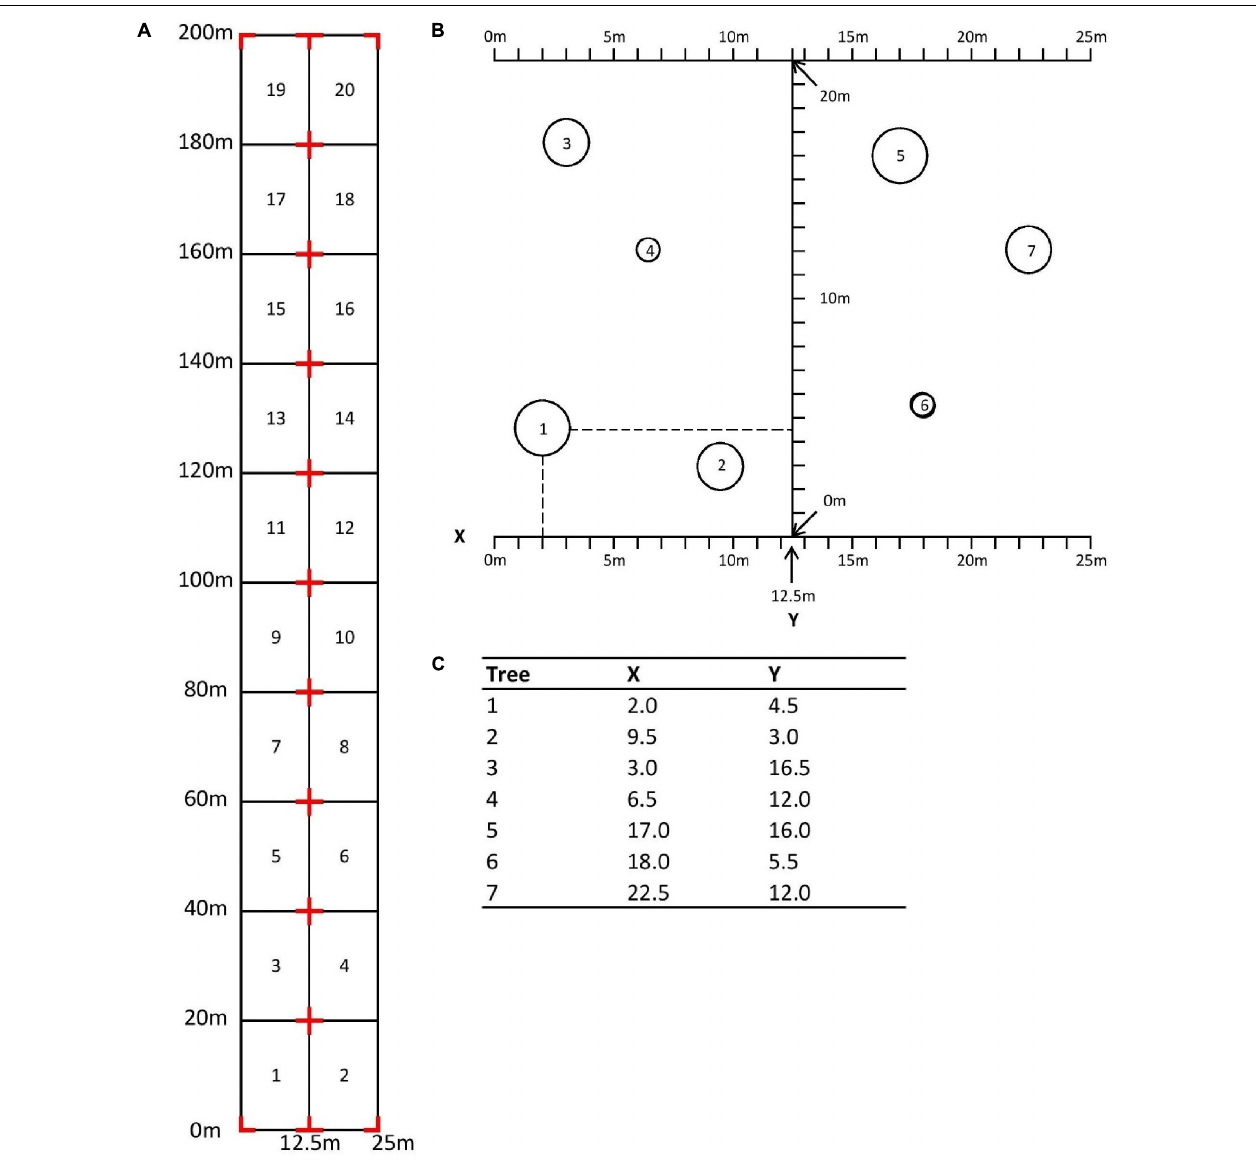
FIGURE 2 | (A). Degradation plot layout, with sub-plot numbers inside boxes. Red crosses show location of points where GPS data should be collected. (B). Diagram explaining how to record XY coordinates of individuals in sub-plots. Dashed line shows point where XY coordinate should be taken (at centre of trunk). (C) . Table shows XY Coordinates for trees 1–7 in